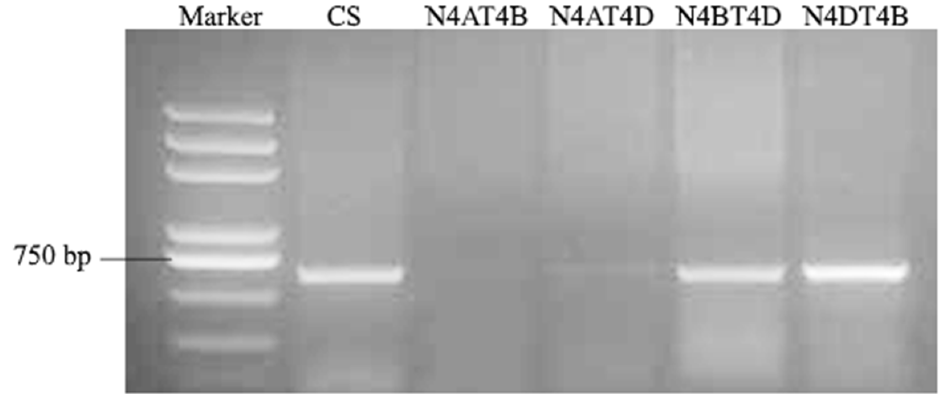
Figure 8. PCR assay to confirm the chromosomal location of TaLecRK-IV.1 based on the amplifica- tion results of the gene-specific primer pair tested on a set of Chinese Spring (CS) nulli-tetrasomic lines.